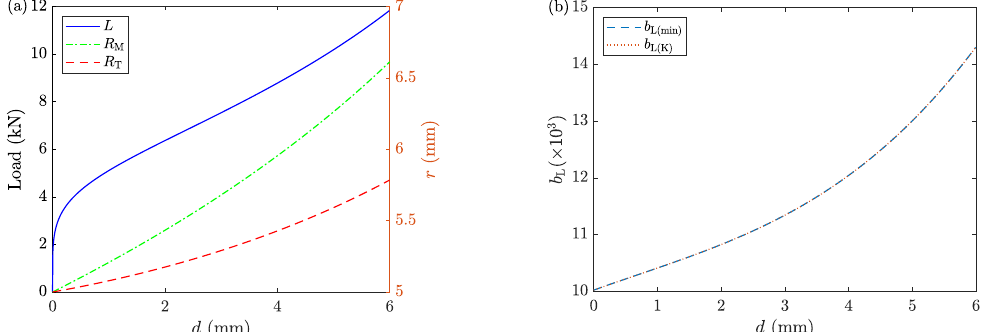
Figure 4. Discretized sample of Case 1 with a grid of 50 at the ( a ) initial and ( b ) final stage of the ACT.